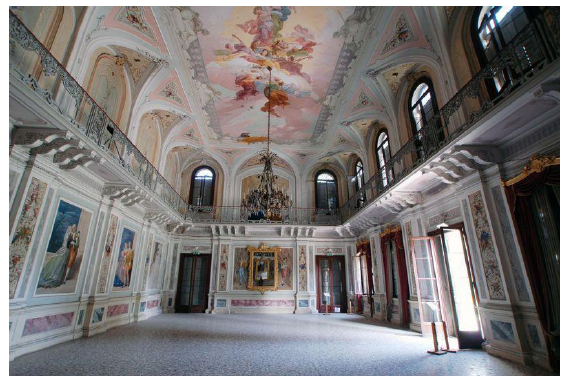
Figure 4: The dance-hall painted by Giacomo Casa